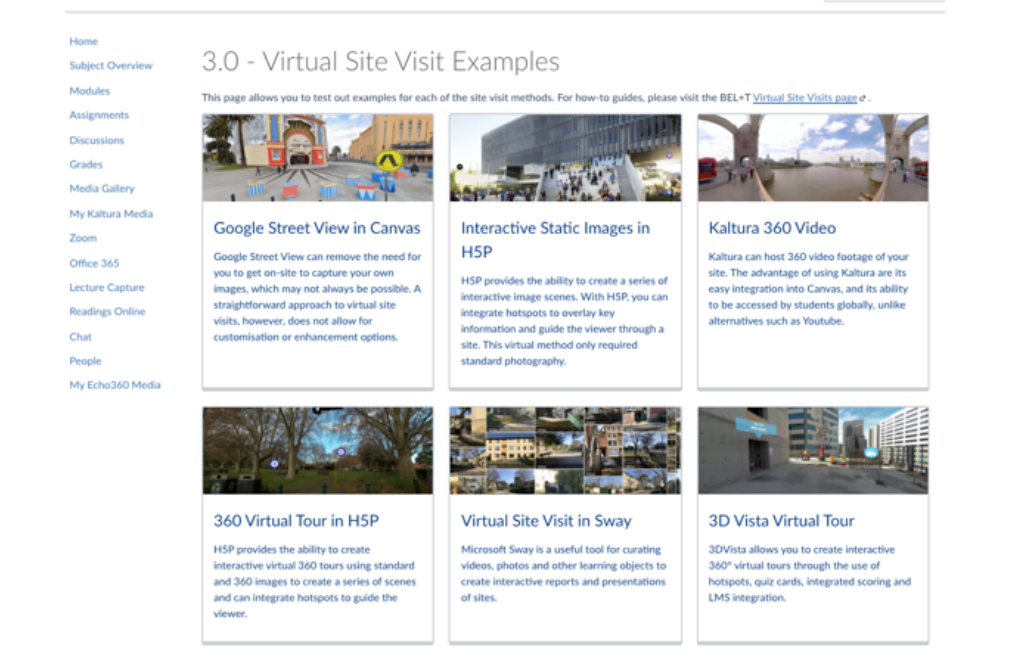
Figure 5. Canvas LMS community site, presenting virtual site visit examples (Source: Site produced by BEL+T to support teaching,